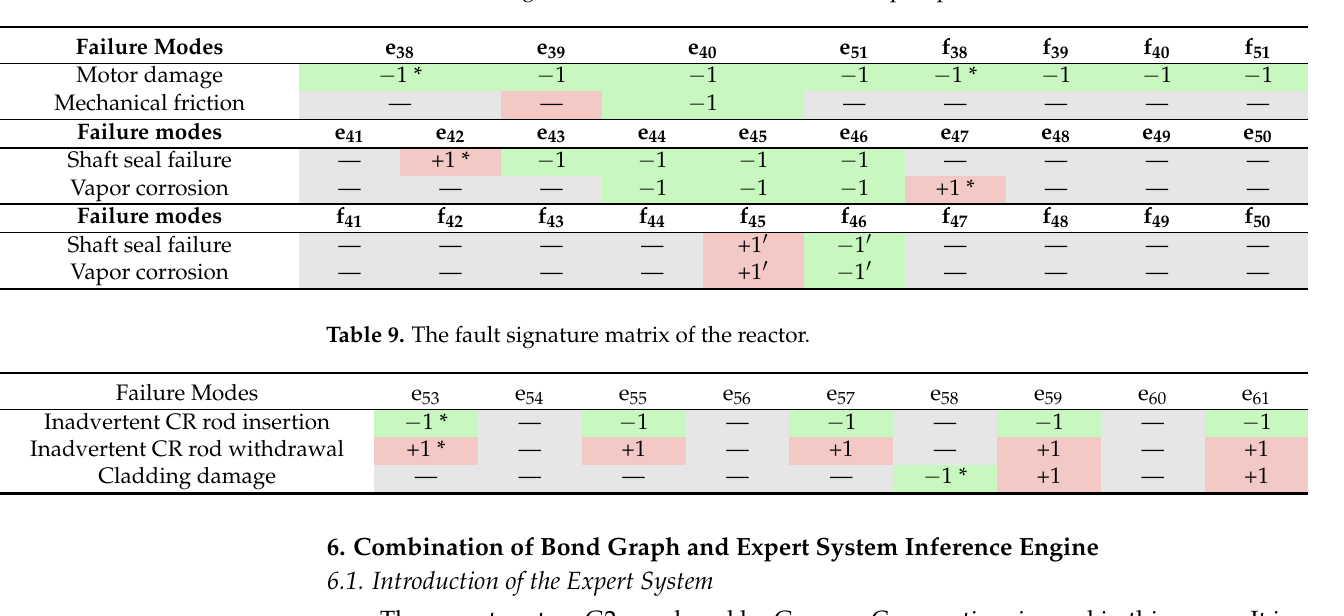
Table 8. The fault signature matrix of the reactor coolant pump.